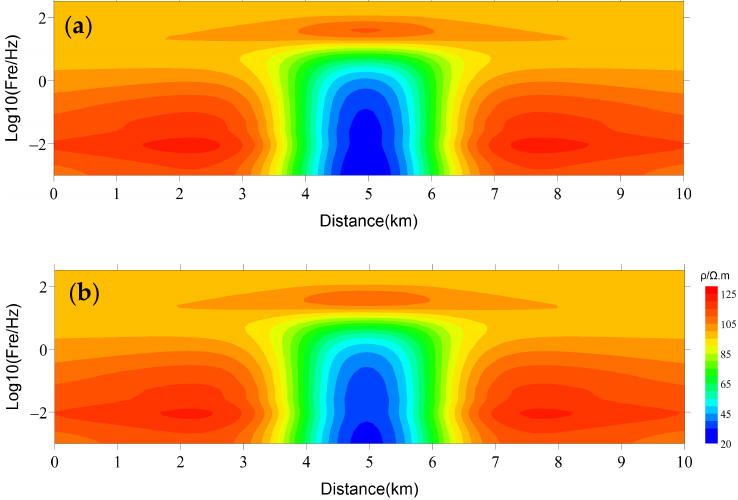
Figure 9. Individual inversion results of apparent-resistivity data in TM mode ( a ); abnormal resistivity-distribution of initial inversion ( b ); abnormal resistivity-distribution of final inversion ( c ).